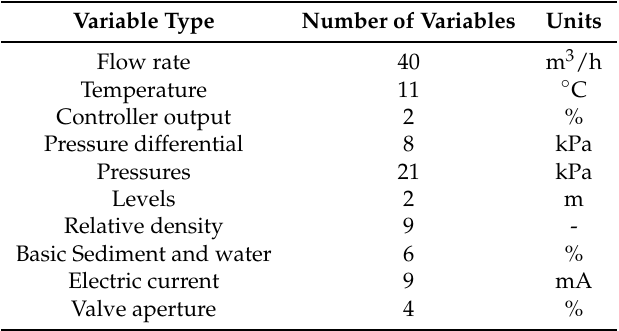
Table 1. Variable types measured in the gas-oil metering station.